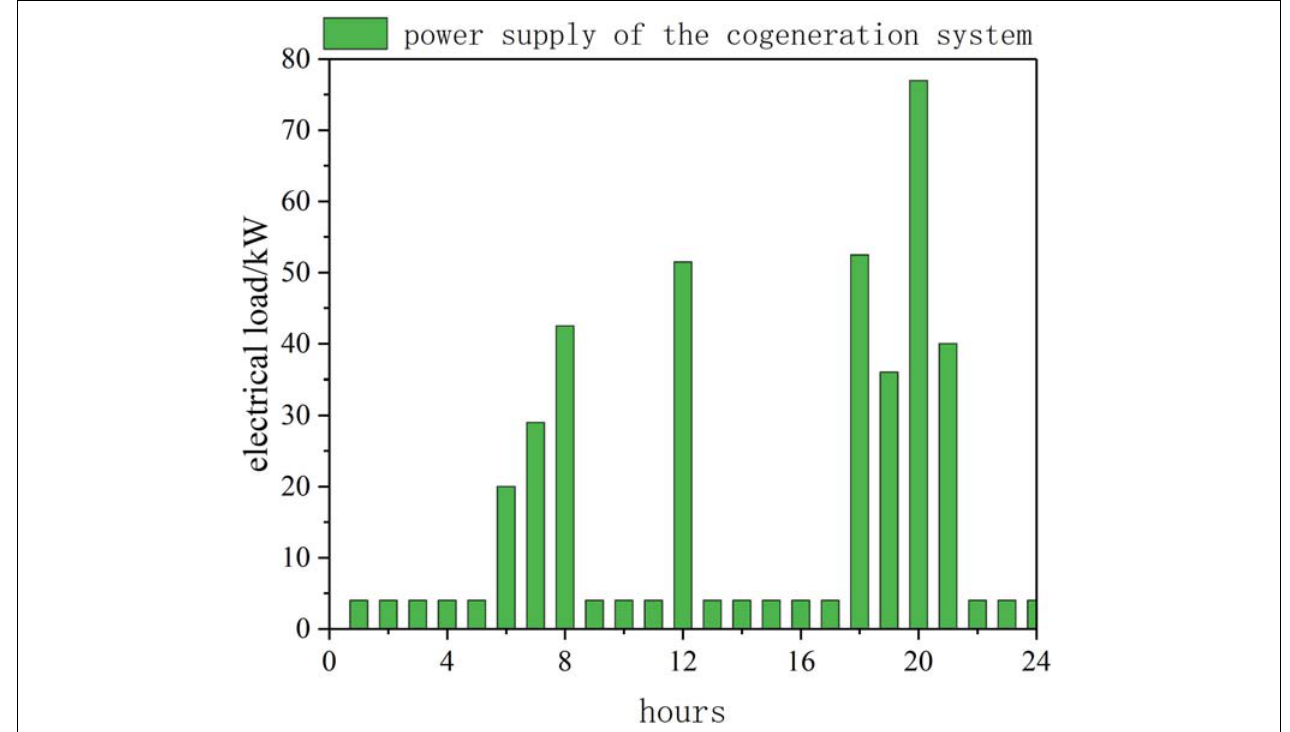
FIGURE 7 | Power supply on a typical winter day.